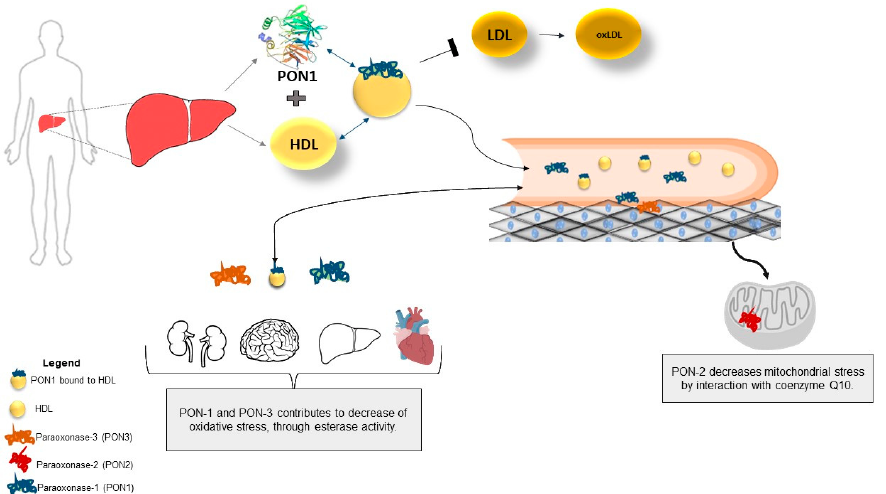
Figure 2. Location and distribution of PON ‐ 1, PON ‐ 2 e PON ‐ 3 in organs and tissues.